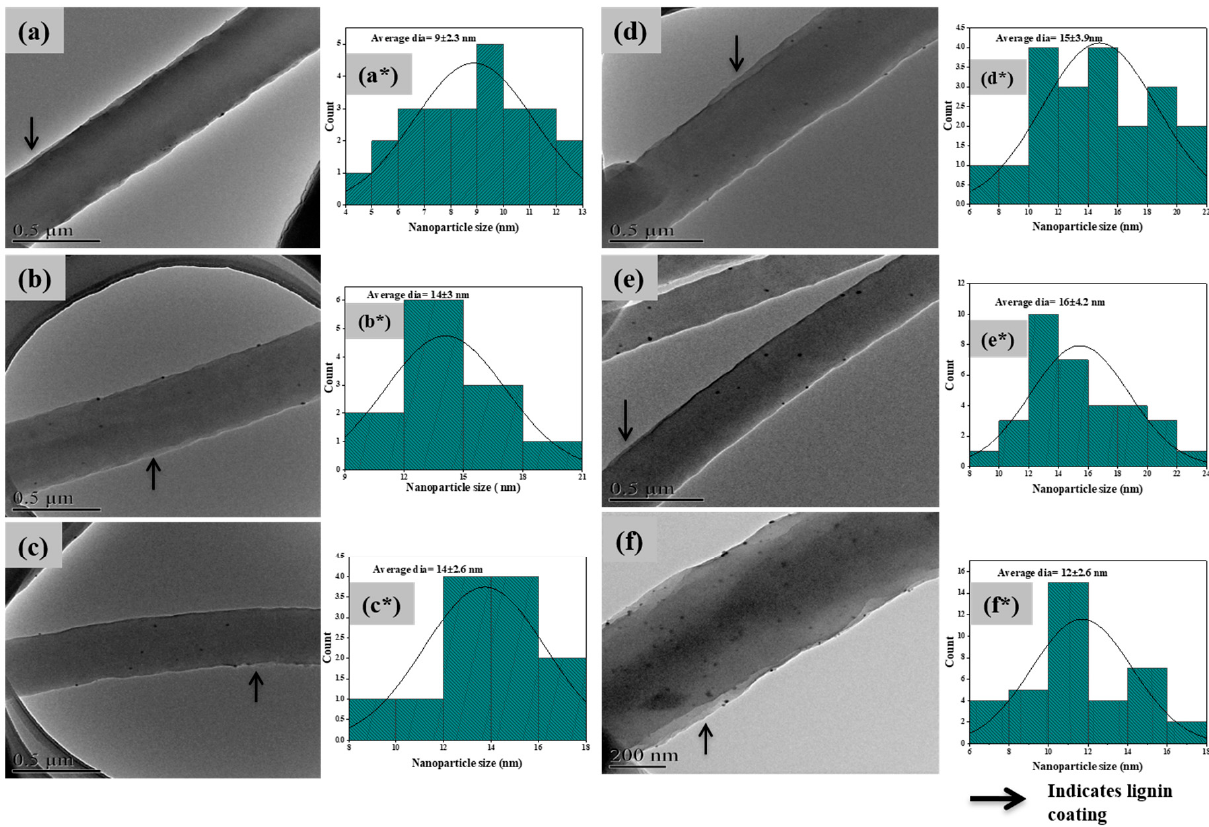
Figure 2. Single fiber Transmission Electron microscope (TEM) images of PAN/AgNPs1 ( a ), PAN/AgNPs2 ( b ), PAN/AgNPs3 ( c ), PAN/AgNPs4 ( d ), PAN/AgNPs5 ( e ), and PAN/AgNPs6 ( f ); nanoparticle size distribution histograms of PAN/AgNPs1 ( a* ), PAN/AgNPs2 ( b* ), PAN/AgNPs3 ( c* ), PAN/AgNPs4 ( d* ), PAN/AgNPs5 ( e* ), and PAN/AgNPs6 ( f* ).